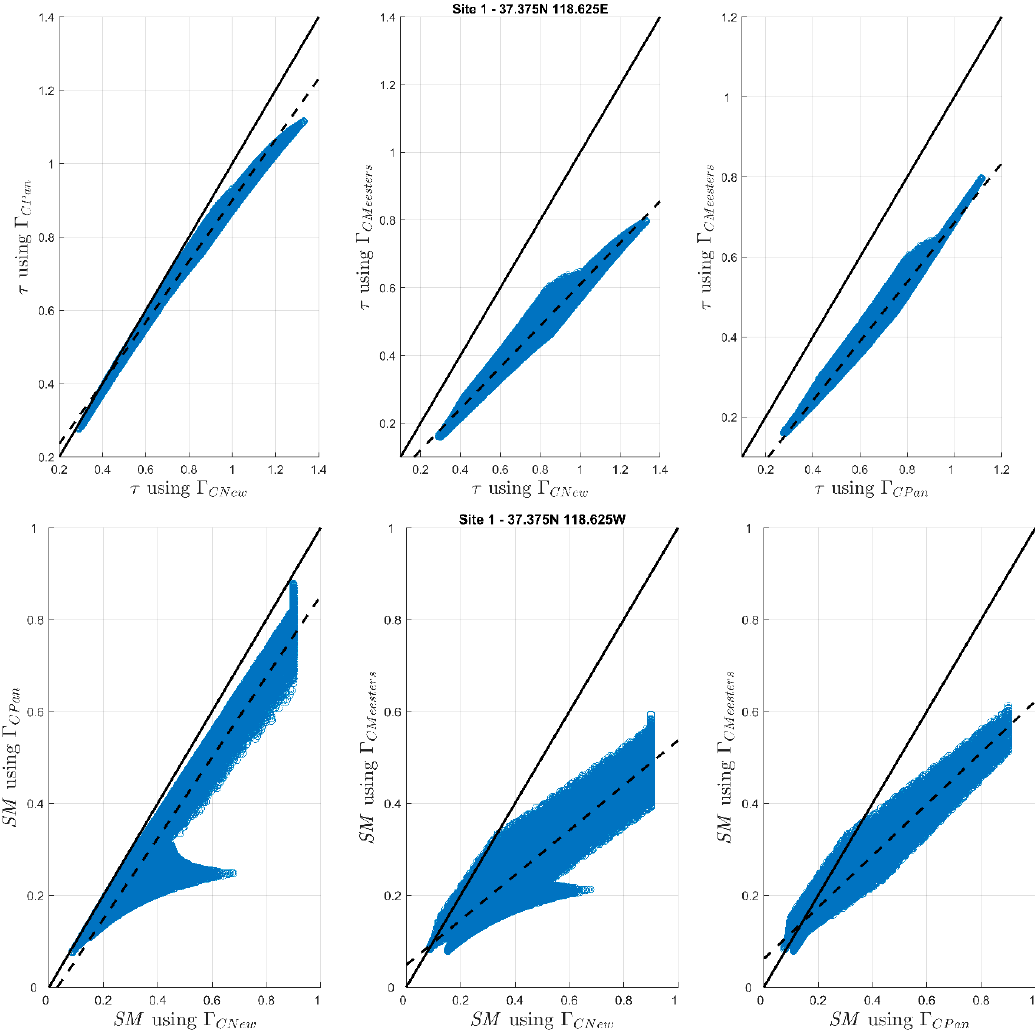
Figure 4. Scatter plots of VOD (top row) and SM (bottom row) simulations pertaining to 50,000 parameter sets ( h , Q , ω ) obtained by altering the analytical solution at Site 1.